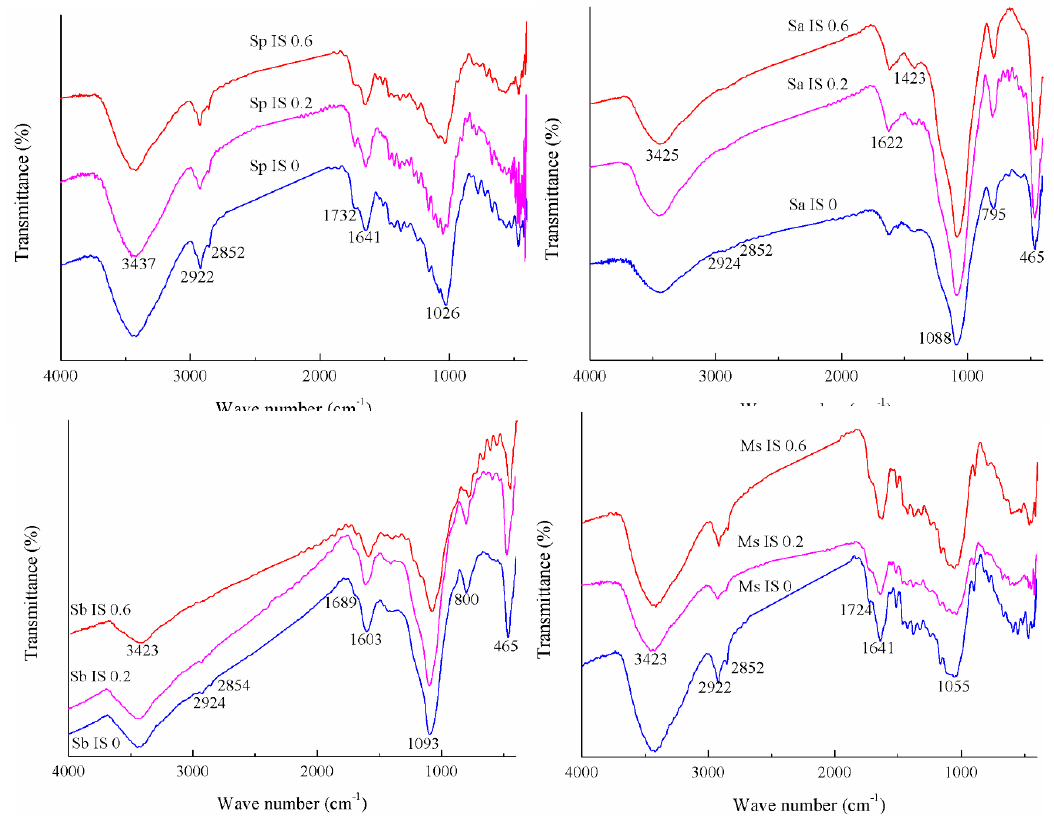
Figure 3. FTIR spectra of Cd(II) adsorbed by the four biosorbents under di ff erent ionic strengths. Note: the specific experiment conditions are as follows: the ionic strengths are set to 0, 0.2 and 0.6 mol / L,